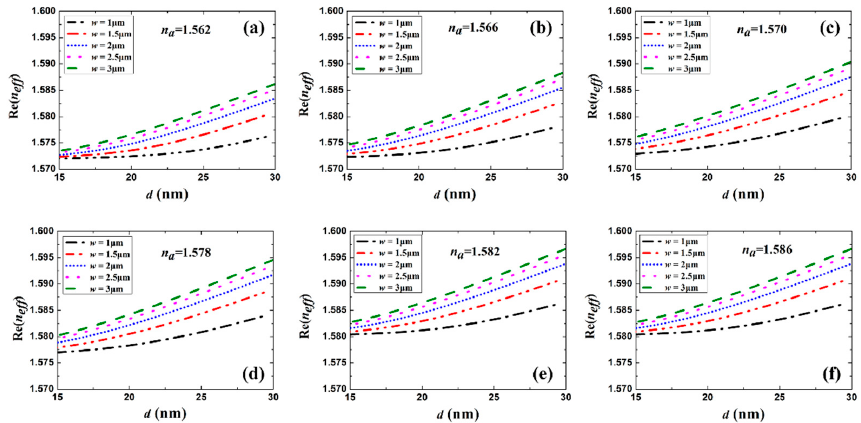
Figure 3. Re( n eff ) as a function of Au stripe thickness d for different stripe widths w and sensing solutions with n a of ( a ) 1.562, ( b ) 1.566, ( c ) 1.570, ( d ) 1.578, ( e ) 1.582 and ( f ) 1.586.